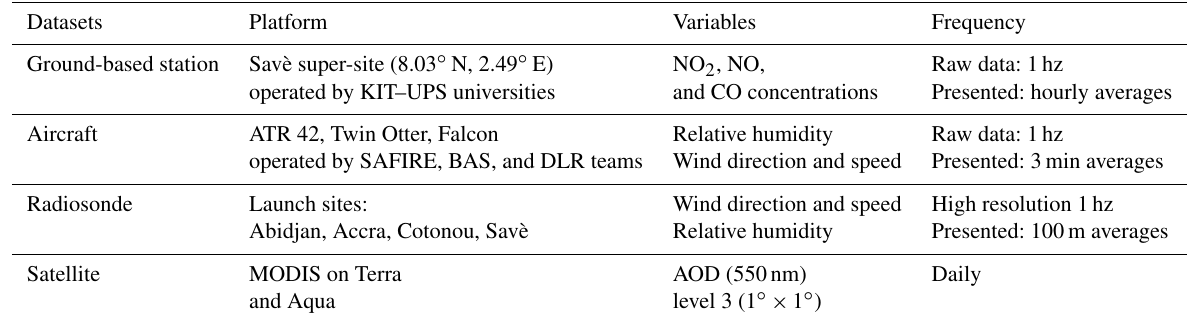
Table 2. Datasets used in this study with acquisition platform, variables, and sampling frequency. Datasets Platform Variables Frequency Ground-based station Savè super-site (8.03 ◦ N, 2.49 ◦ E) NO 2 , NO, Raw data: 1hz operated by KIT–UPS universities and CO concentrations Presented: hourly averages Aircraft ATR 42, Twin Otter, Falcon Relative humidity Raw data: 1hz operated by SAFIRE, BAS, and DLR teams Wind direction and speed Presented: 3min averages Radiosonde Launch sites: Wind direction and speed High resolution